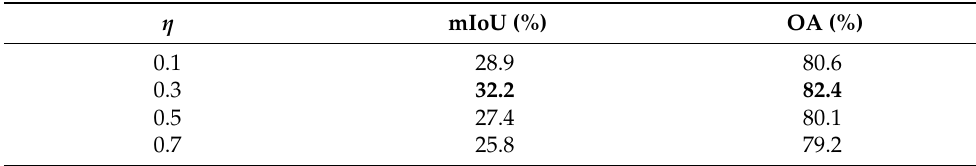
Table 5. The effect of different hyperparameter settings on CAM quality as measured by the mIoU (%) and OA (%).